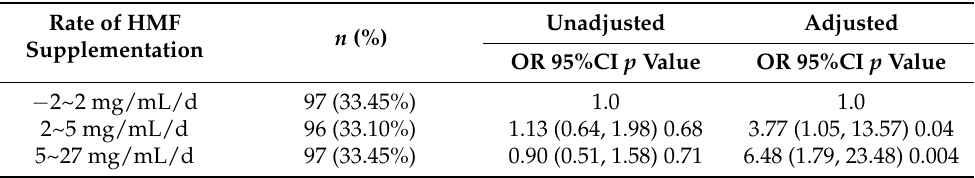
Table 6. Univariate and multivariate logistic regression to assess the association of rate of HMF supplementation with FI. Dates,